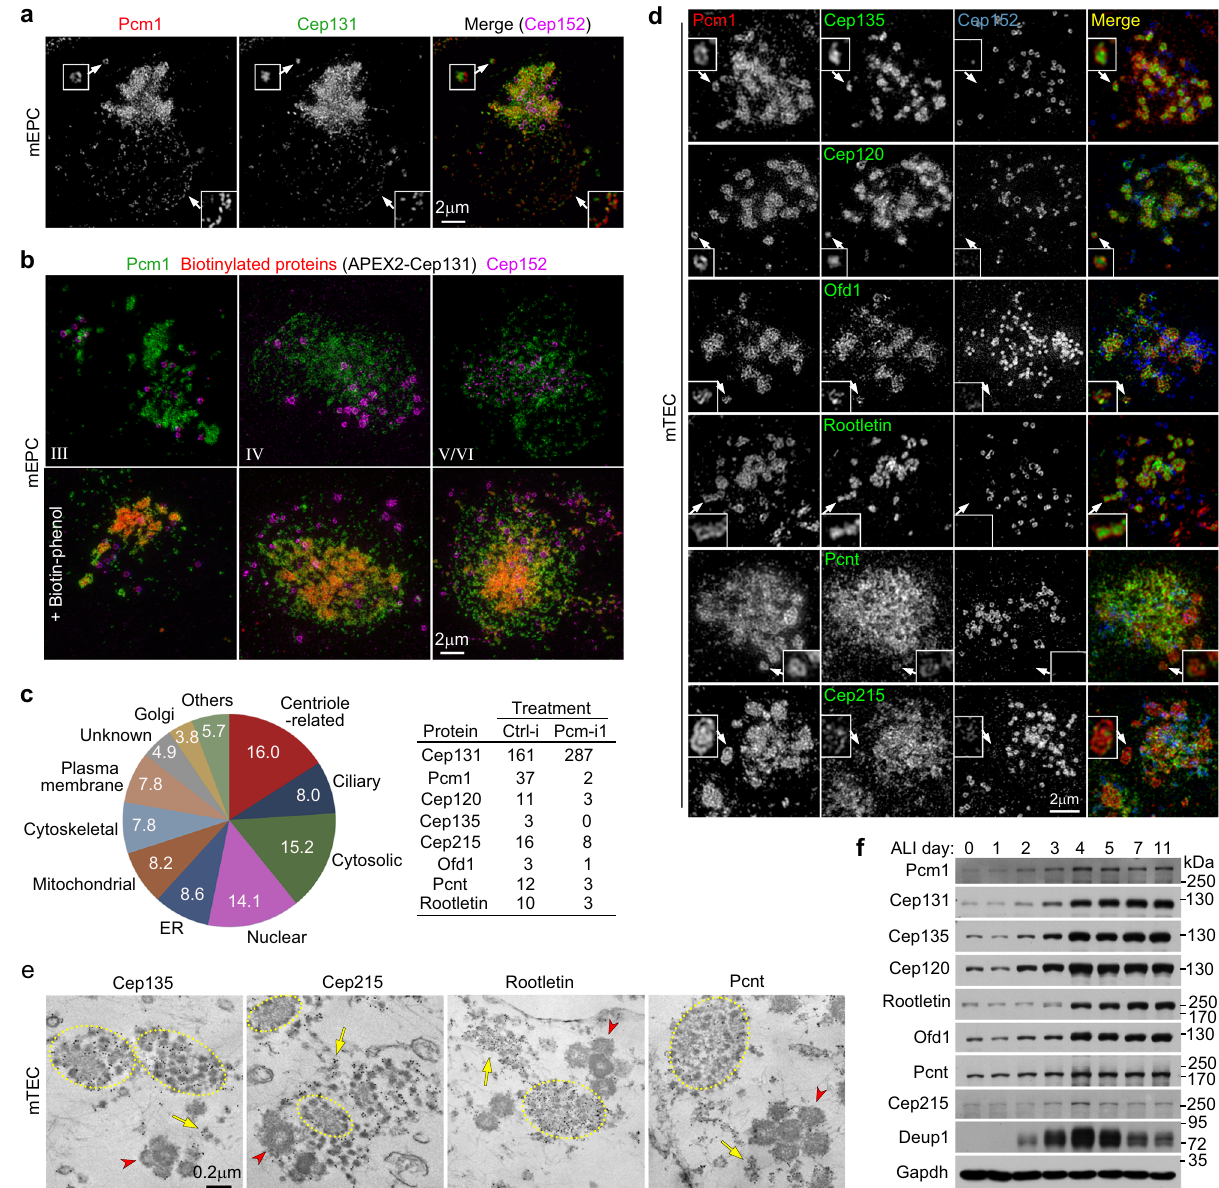
Fig. 4 Proximity labeling through APEX2-Cep131 identi fi es multiple FGM components. a Cep131 colocalized with Pcm1 in FGMs. mEPCs fi xed at day 3 postserum starvation were immunostained and imaged by 3D-SIM. Cep152-labeled deuterosomes served as MCC marker. The magni fi ed insets show details for cytoplasmic (top) and perinuclear (bottom) FGMs. b APEX2-Cep131 induced biotinylation of FGM proteins. mEPCs infected with adenovirus at day − 1 to express APEX2-Cep131 were either mock-treated (upper panels) or treated with biotin-phenol and H 2 O 2 to trigger the proximity labeling reaction (lower panels) at day 3, followed by fl uorescent staining and 3D-SIM. Biotinylated proteins were visualized with Alexa Fluor 546-labeled streptavidin 30 . c FGM candidate proteins identi fi ed by differential mass spectrometric analysis. APEX2-Cep131-expressing mEPCs were transfected respectively with Ctrl-i and Pcm-i1, followed by the proximity labeling with biotin-phenol. The biotinylated proteins were precipitated using streptavidin resin and subjected to shotgun mass spectrometry. The pie chart indicates protein compositions according to subcellular localizations. The table lists peptide spectrum matches (PSM) of Pcm1 and seven newly identi fi ed FGM proteins in the control (Ctrl-i) and Pcm1-depleted mEPC samples. d Subcellular localization of the indicated FGM components with Pcm1 in mTECs at day 3. Insets are magni fi ed images of typical FGM cores. e Immuno-EM con fi rmed FGM localization of the indicated proteins in mTECs at day 3. Cep135 and Cep215 were immune-labeled with 10-nm gold particles, whereas Rootletin and Pcnt by 5-nm gold particles. Arrows indicate loose FGMs. FGM cores are encircled. Arrowheads point to typical procentriole-deuterosome complexes. Immuno-EM experiments were performed once. f Expression pattern of the FGM proteins. mTECs collected at the indicated ALI days were used for immunoblotting. Deup1 served as deuterosome marker. Gapdh served as loading control. Two biologically independent experiments were performed and images from the same experiment were presented. Source data are provided in the Source data fi